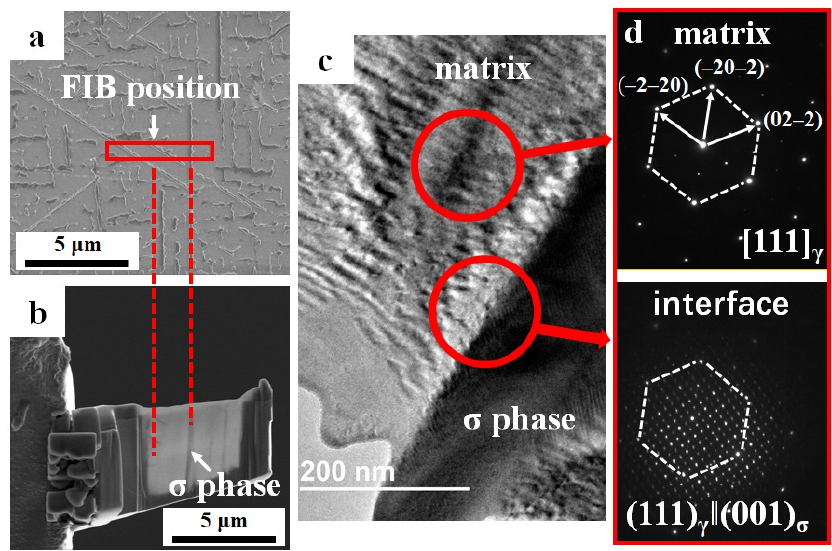
Figure 3. ( a ) SEM image showing the FIB position; ( b ) FIB sample with the σ phase; ( c ) TEM bright field image showing matrix and σ phase; ( d ) diffraction patterns of matrix and interface with [1 1 1] beam direction.